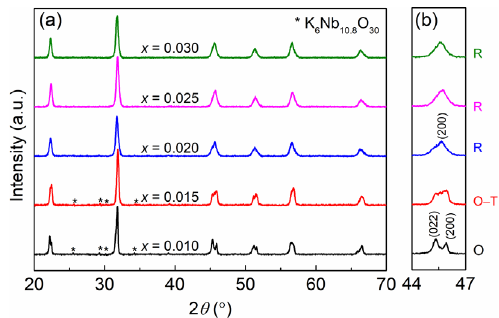
Fig. 1 XRD patterns of (1 − x )KNN– x BZN ceramics with different BZN contents: 2  (a) from 20° to 70° and (b) from 44° to 47°.